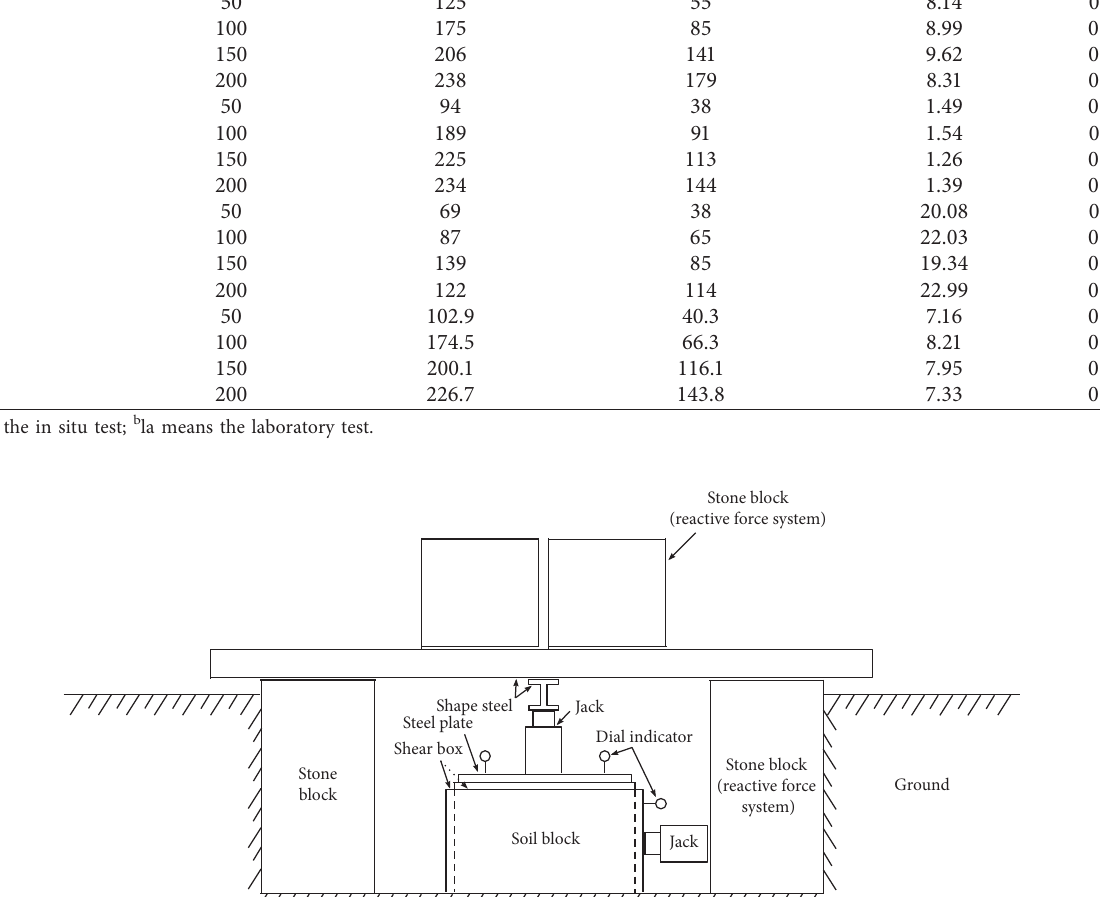
Figure 8. The stress data of the samples in natural condition are not illustrated for clarity. Linear fitting is used to obtain the strength parameters, and the equations are also given in the figure. From the fitted equations, the strength parameters from the in situ test can be obtained, as shown in Table 3.